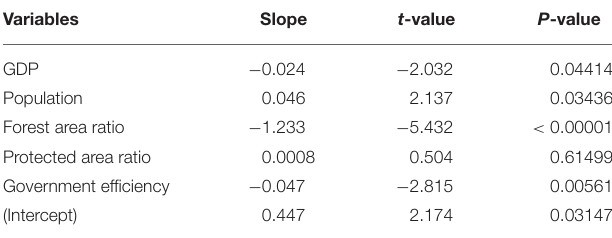
TABLE 5 | Statistical results for the